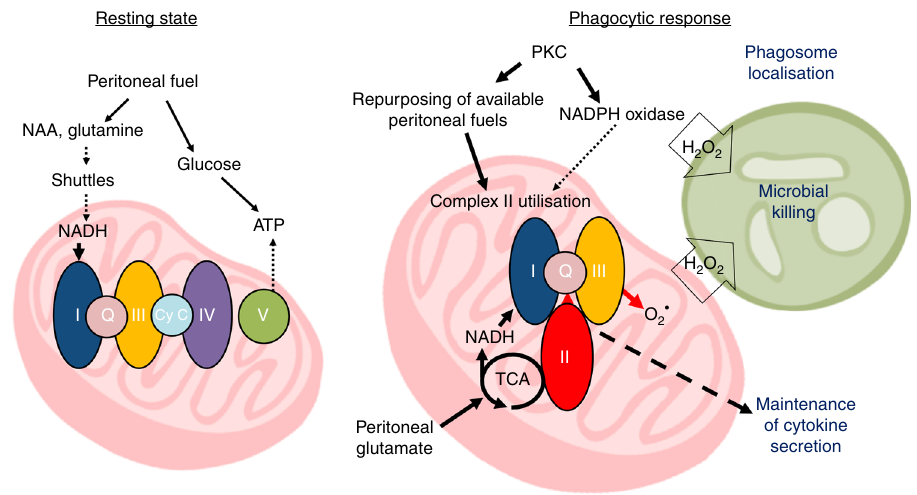
Fig. 10 Peritoneal tissue-resident macrophages are metabolically poised to engage microbes using tissue-niche fuels Model showing the proposed metabolic phenotypes of resting- and phagocytic-peritoneal tissue-resident macrophages and how this impacts function. NAA, N-acetyl aspartate; PKC, Protein kinase C; Shuttles, malate-aspartate or citrate-malate mitochondrial shuttle